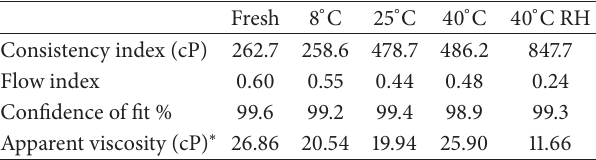
Table 4: Results of rheological analysis followed for 30 days.